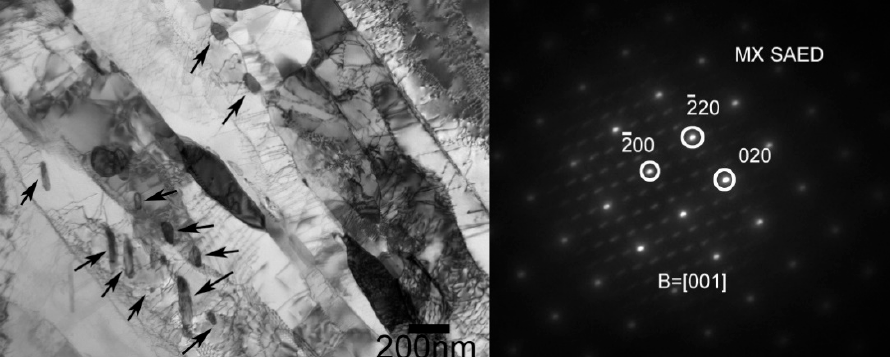
Figure 7. TEM micrographs and the related SAED of MX in 15Cr12MoVWN specimen normalized at 1080 °C and tempered at 760 °C.